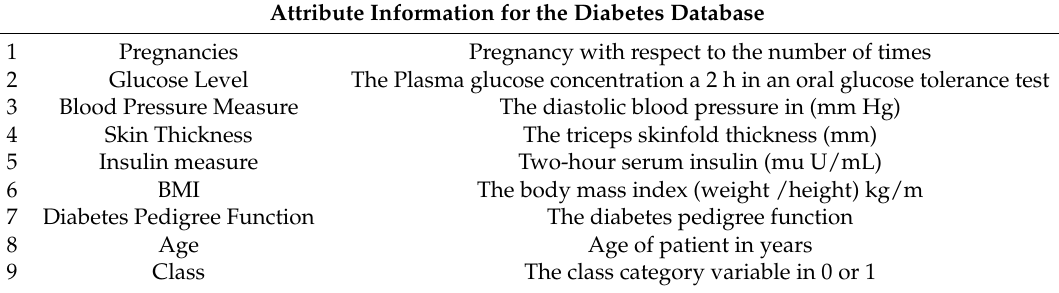
Table 4. Diabetes dataset description.